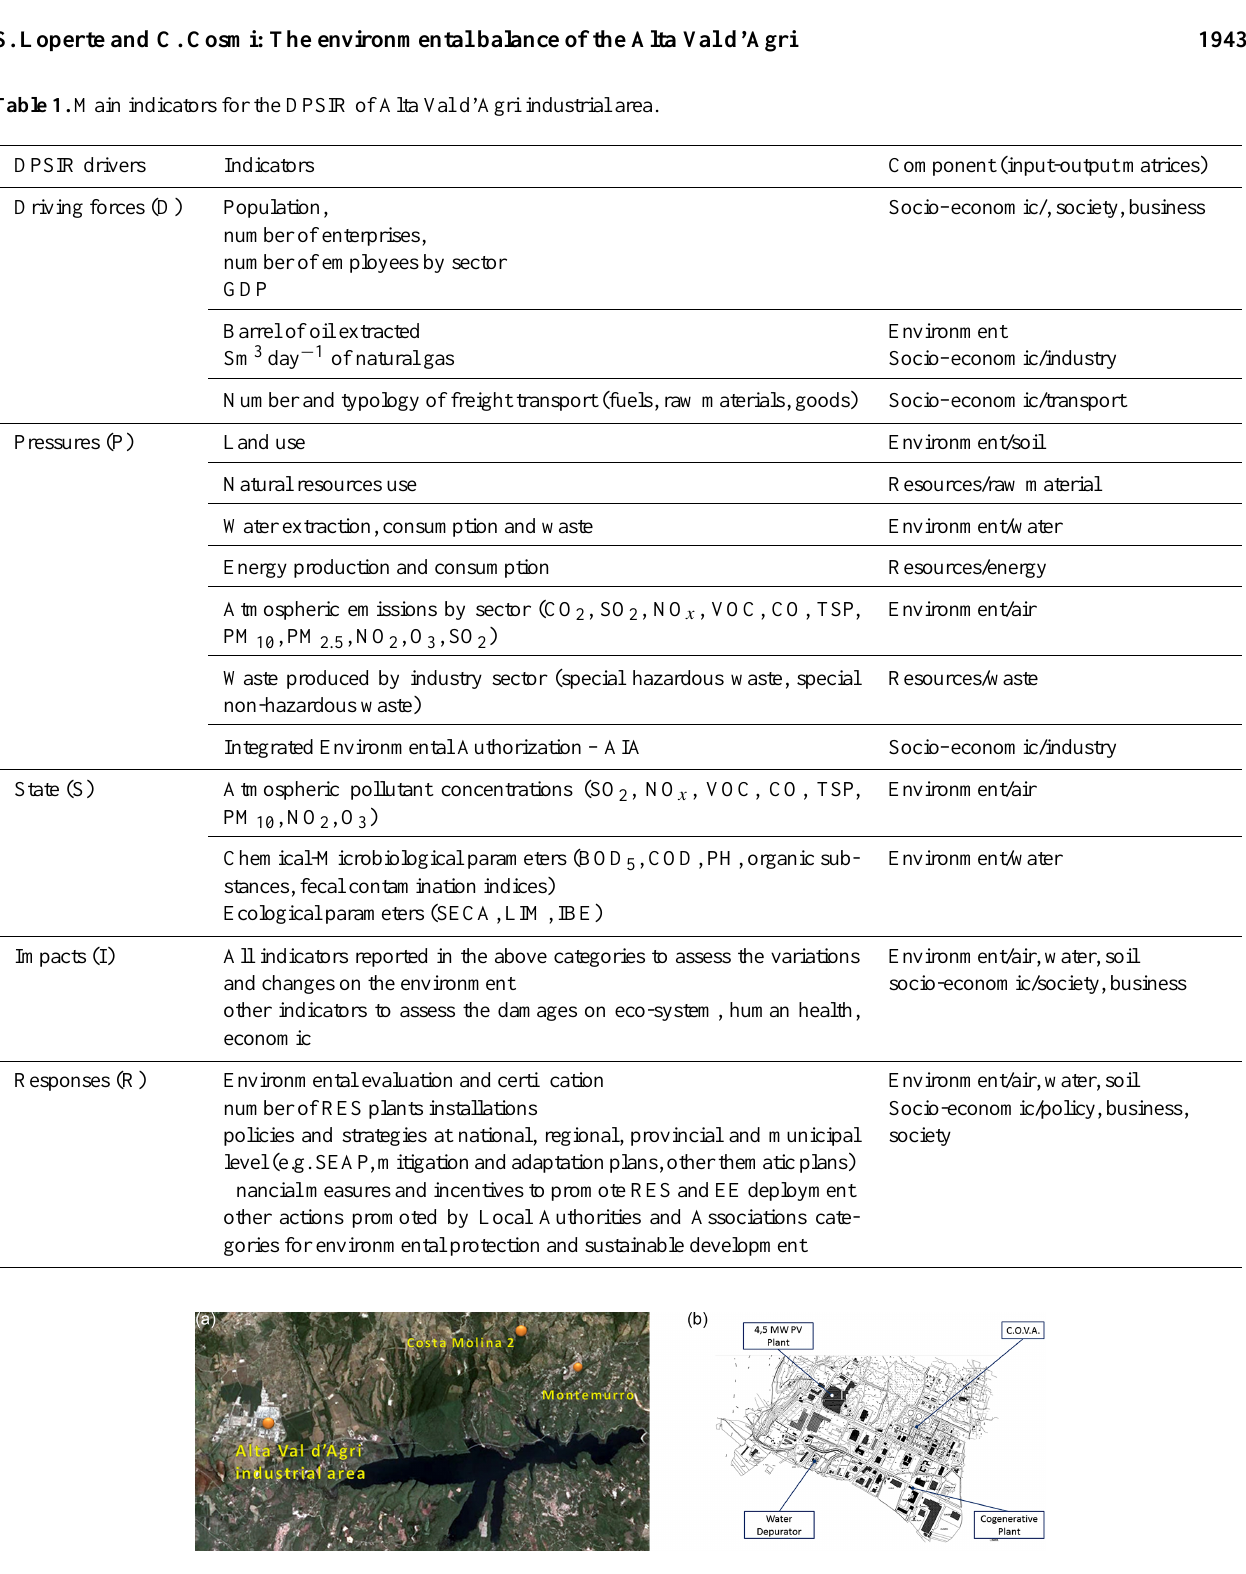
Figure 1. (a) Map of the analyzed area in which are highlighted the Alta Val d’Agri industrial area, the location of wastewater reinjection well (Costa Molina 2) and Montemurro (source: Google Earth, 2013), and ( b) site plan of Alta Val d’Agri industrial district with the most relevant industrial activities highlighted by the boxes (Source: CNR-IMAA elaboration on Bonaduce’s